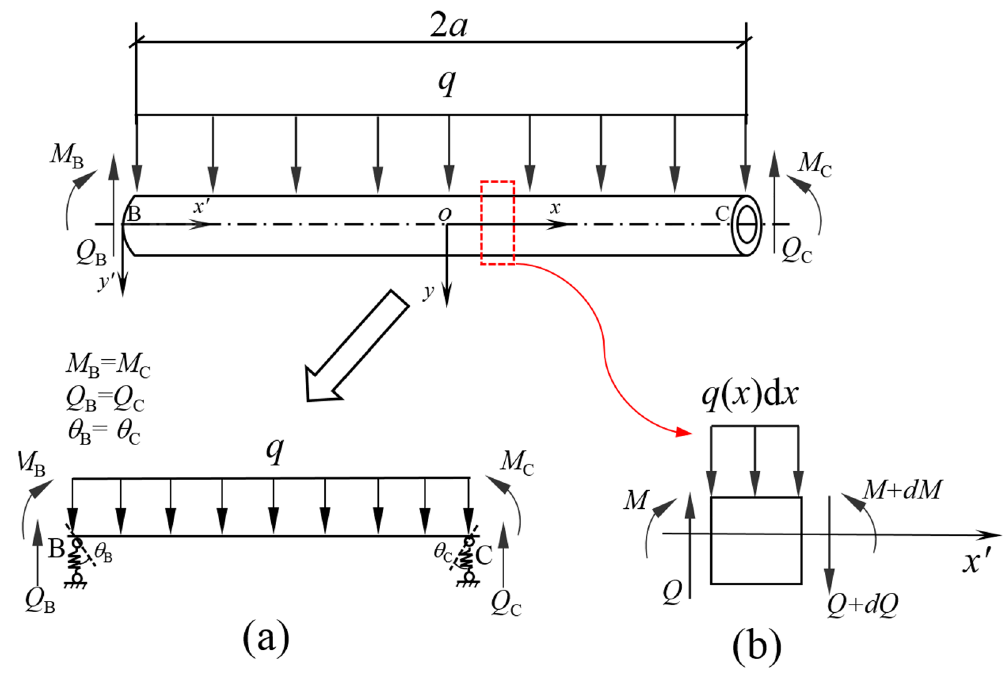
Figure 6. Calculation model of void zone, ( a ) simplified model; ( b ) infinitesimal element